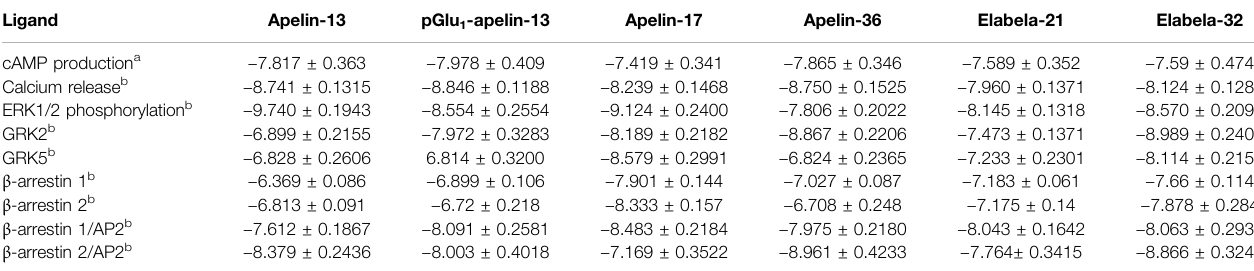
TABLE 2 | Ef fi cacy or inhibitory potency of each ligand on different